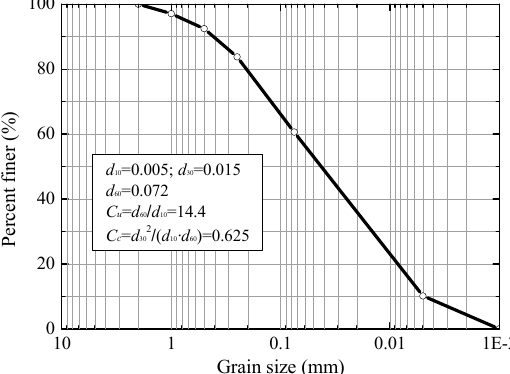
Figure 1. Grain-size distribution of silty clay.